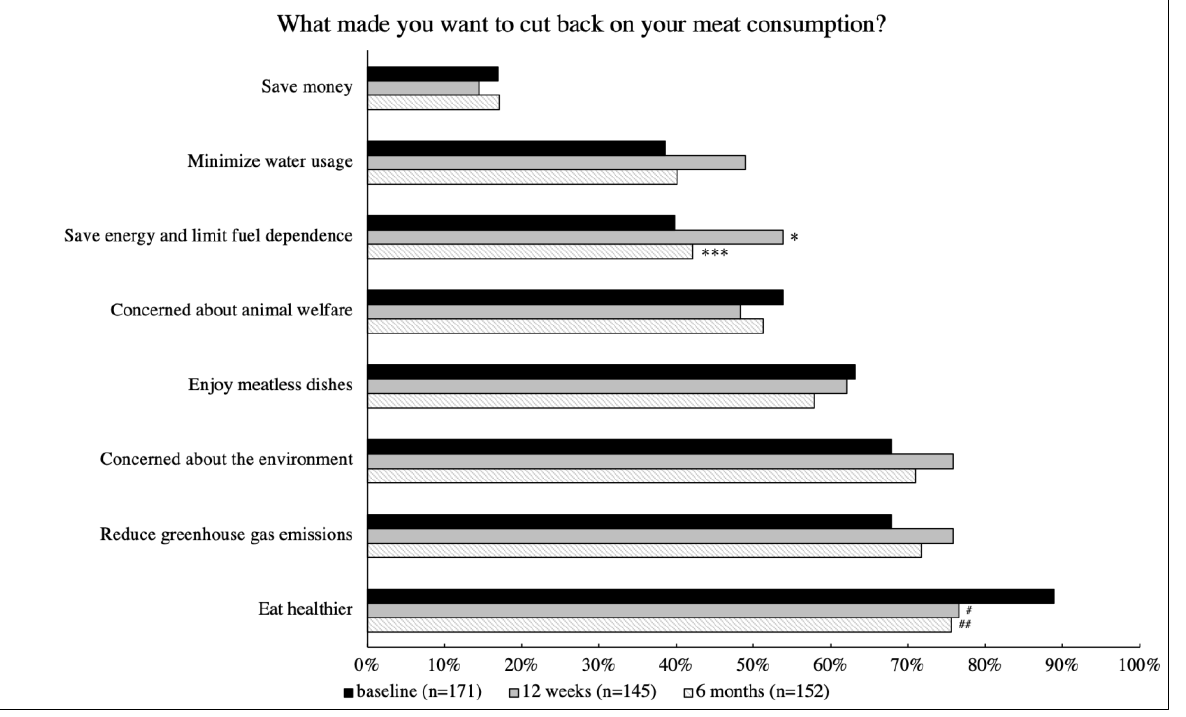
* denotes a significant difference ( p <0.05) between baseline and 12 weeks; *** denotes a significant difference ( p <0.05) between 12 weeks and 6 months; # denotes a significant difference ( p <0.01) between baseline and 12 weeks; ## denotes a significant difference ( p <0.01) between baseline and 6 months ( p